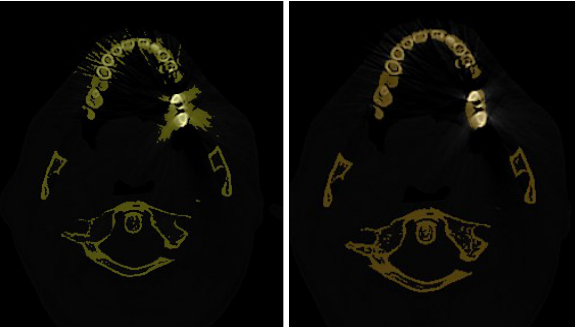
Fig. 4. Manual removal of artifacts caused by the presence of metal.